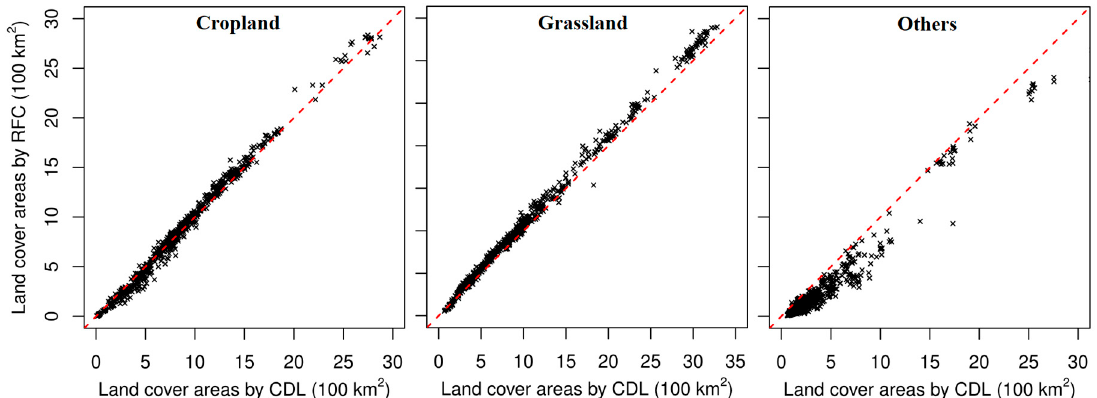
Figure 2. County-level comparison between estimated land cover area from this study and the Cropland Data Layer (CDL). A total of 726 data points (66 counties × 11 years) were plotted.